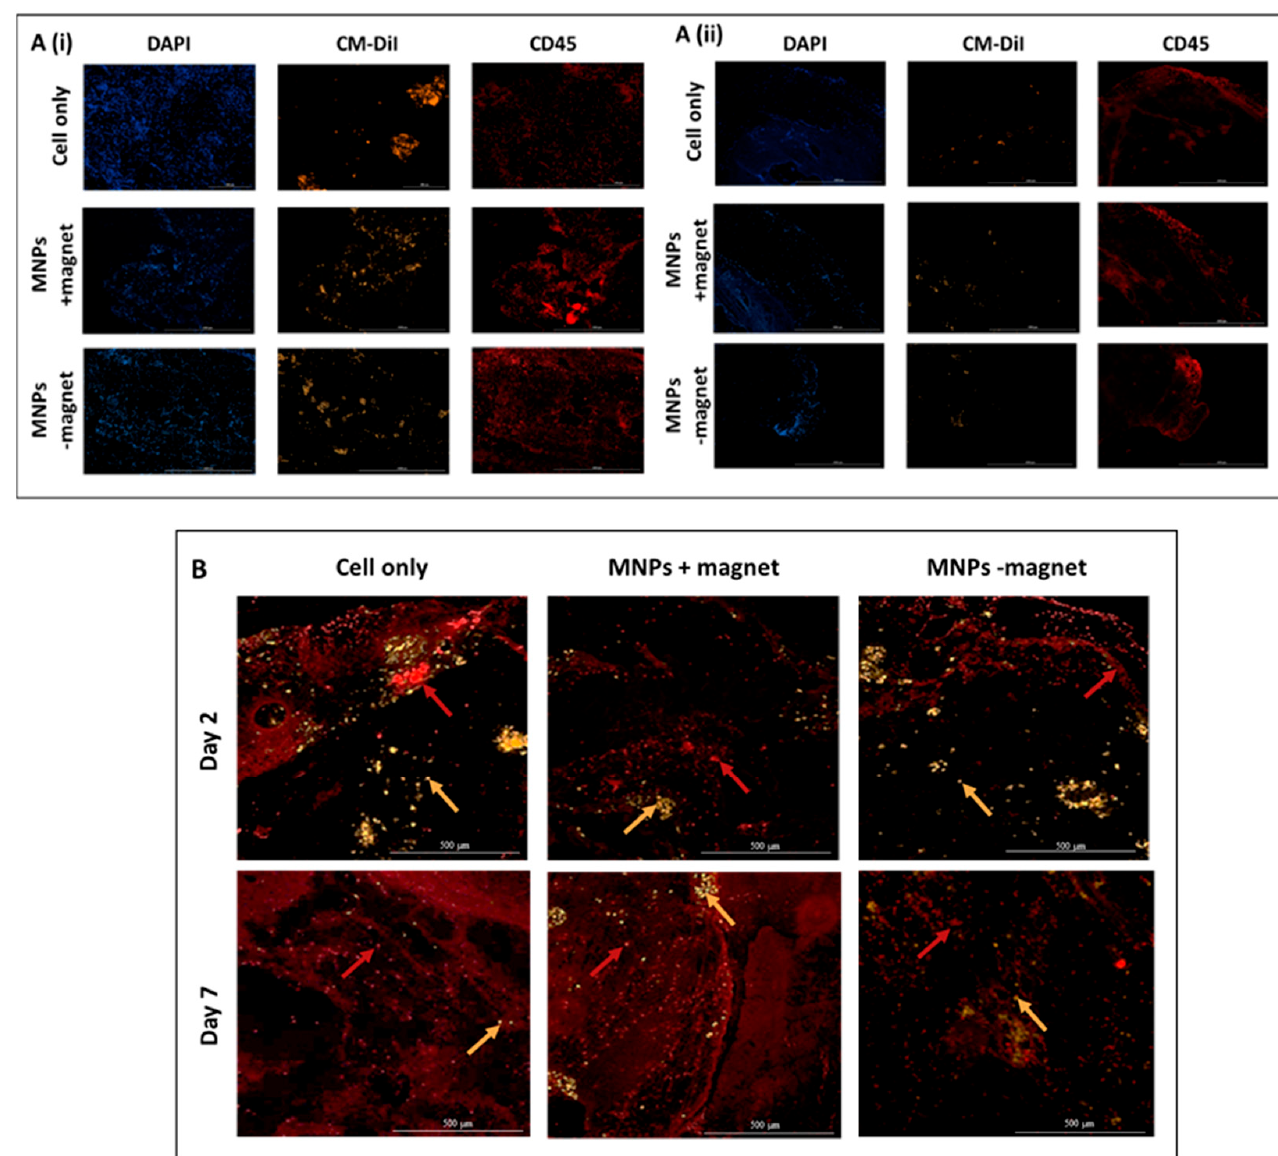
Figure 5. Characterisation of cell infiltration by immunohistochemistry staining for ( A ) CD45 and ( B ) STRO-4 for representative samples at day 2 (Ai) and day 7 (Aii) for the following groups: cell only, MNPs +magnet and MNPs − magnet. DAPI (blue staining) was used for the cell nuclei, CM-Dil (orange fluorescence) identifies implanted oMSCs, whilst the presence of CD45- or STRO-4-positive cells are depicted by red fluorescence. A red arrow indicates an example of STRO-4-positive endogenous cell. An orange arrow indicates an example of the implanted CM-Dil-positive cell. Scale bar = 100 µm (5A) and 5000 µm (5B).